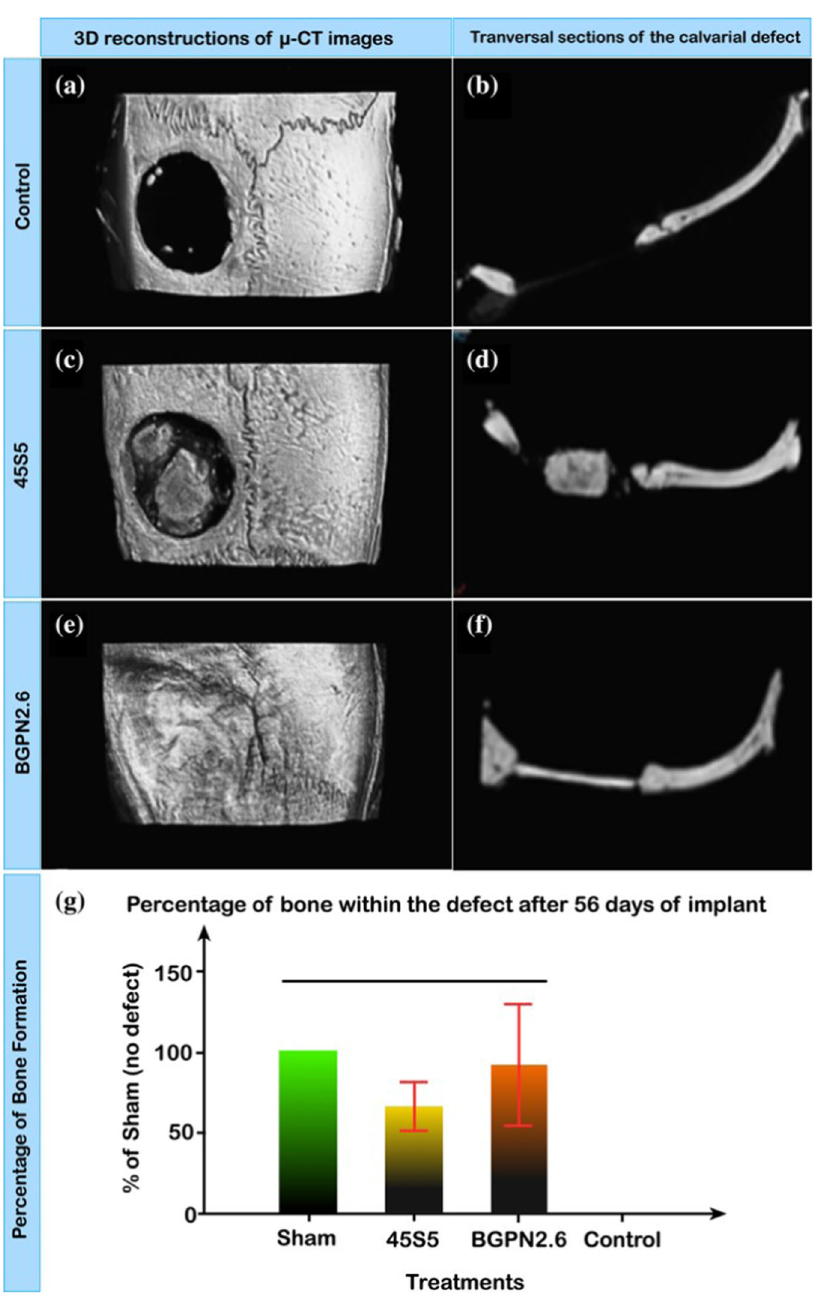
Fig. 5 Microcomputed tomography images showing bone regeneration in a 5-mm critical-size defect in rat calvaria after 56 days [233]. Reproduced with permission from John Wiley and